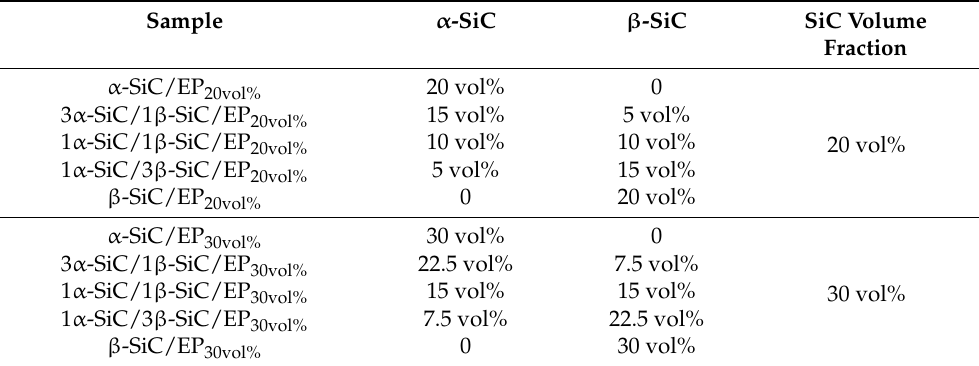
Table 2. SiC/EP composites filled with different crystal forms of SiC particles.